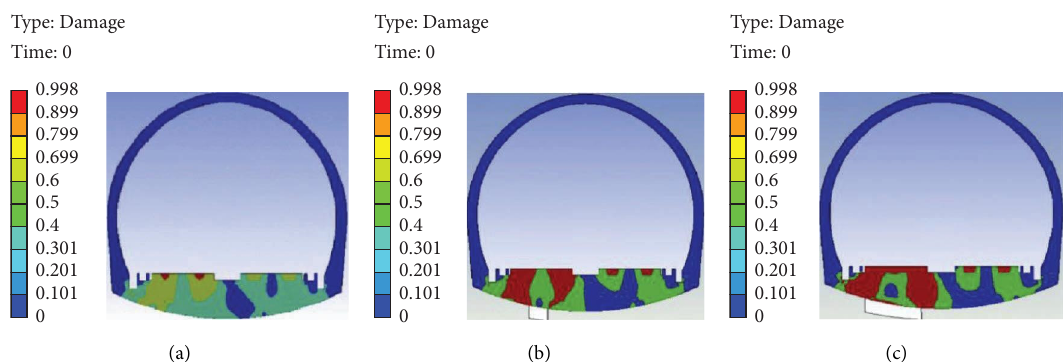
Figure 20: Distribution characteristics of substructure damage in three stages of surrounding rock in the 80th year of operation: (a) denser; (b) local cavity; (c) cavity connection.